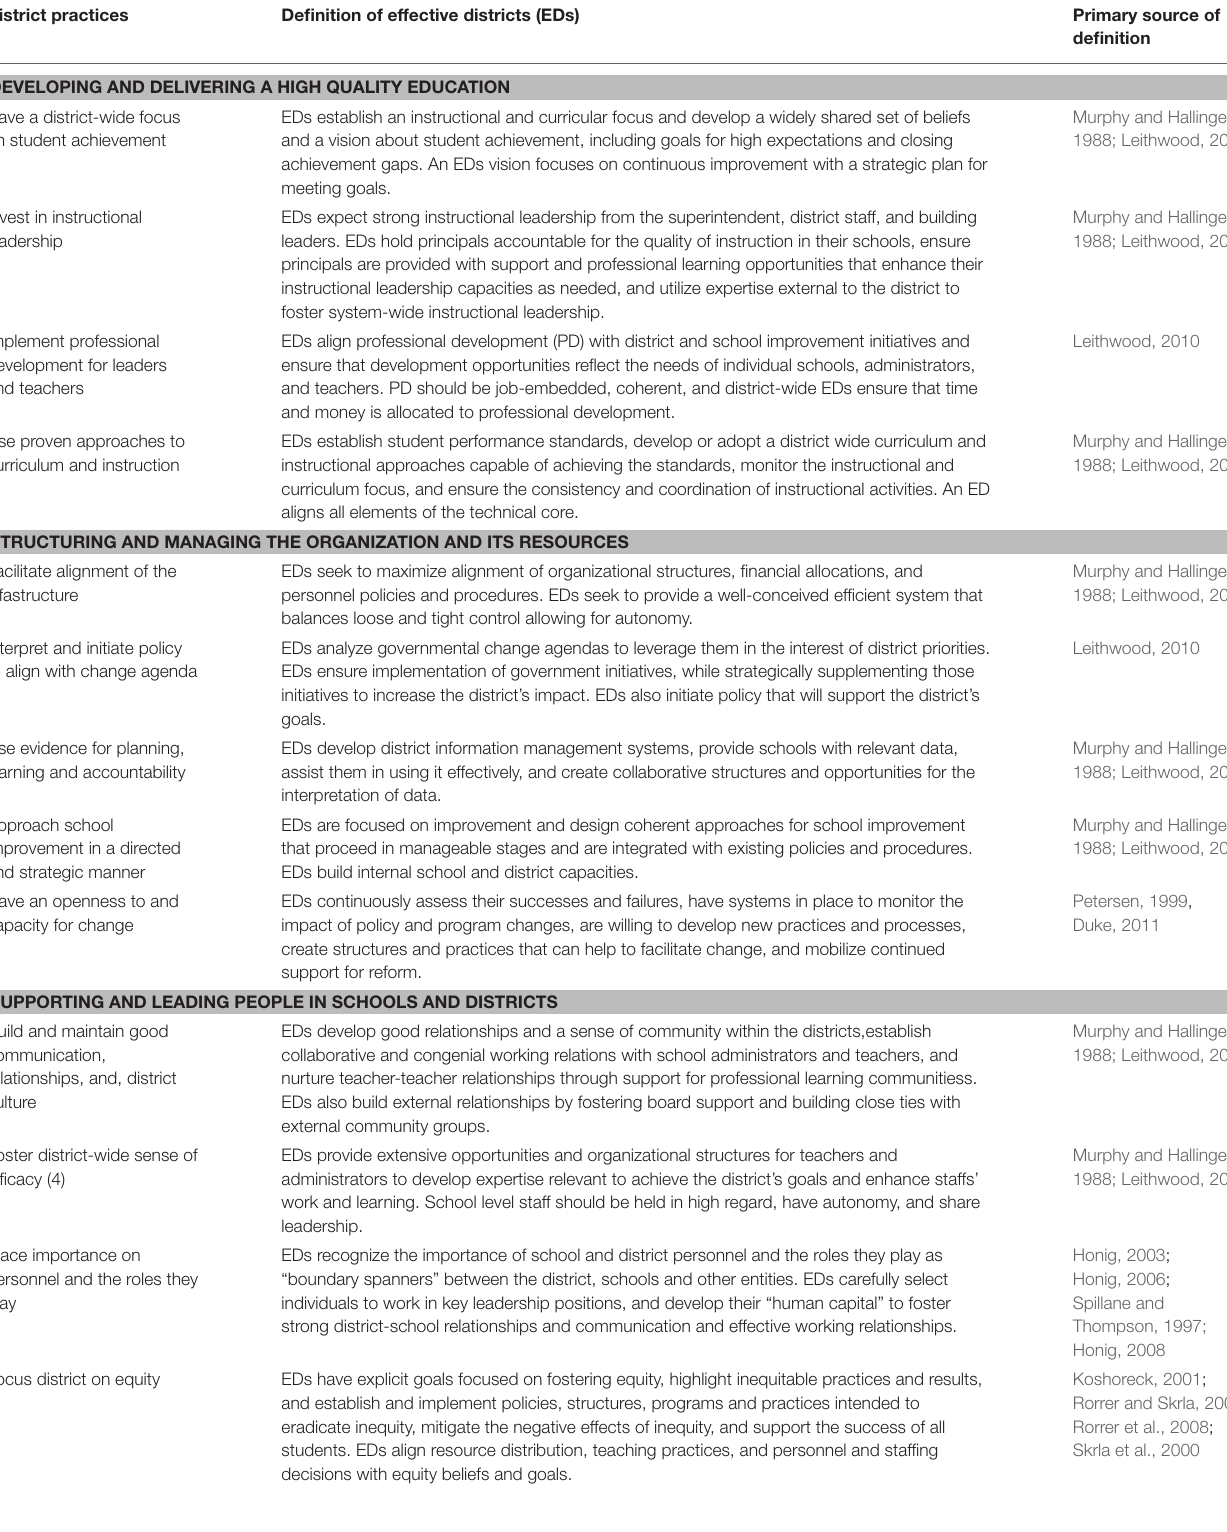
TABLE 1 | A Framework for District